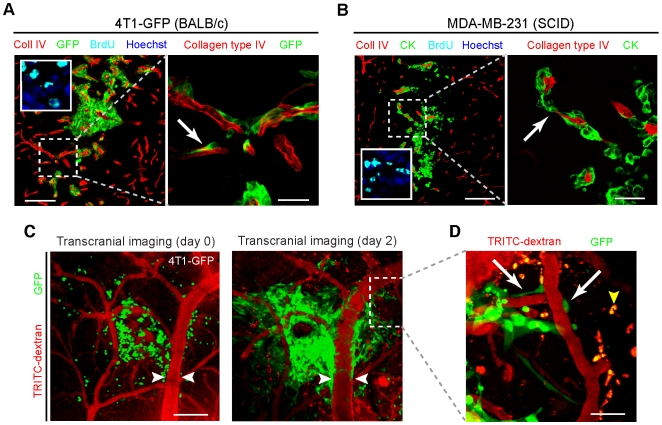
Vascular preference for CNS growth of carcinoma cells in vivo.104 (A) 4T1-GFP or (B) MDA-MB-231 cells were injected directly into the forebrain of mice. Representative coronal sections are shown after 4 d and demonstrate angiotropic growth (left; inset, BrdU from the main tumor mass on an adjacent section). The right panels show a magnification of the hatched areas on the left further documenting the interaction of the tumor cells with the vessels, in this case angiocentric invasion (arrows). Scale bars, 120 µm (left), 30 µm (right). (C) Serial transcranial confocal/multiphoton imaging through a cranial window showed that colony expansion occurred along pre-existing vessels in vivo (n = 5 mice). Day 0 (left), Day 2 (right). Note dilatation of coopted vein compared to day 0 (white arrowheads). Scale bars, 240 µm. (D) Detail of hatched area in (C) demonstrates tumor cells now present in previously uninvolved areas with extensive spreading on pre-existing vessels (arrows). Yellow arrowhead, TRITC-dextran laden phagocytes. Scale bars, 30 µm.